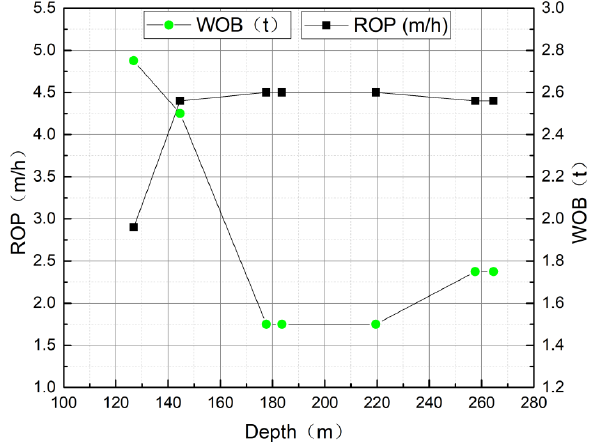
Figure 8. Relationship of WOB and ROP with drilling depth.